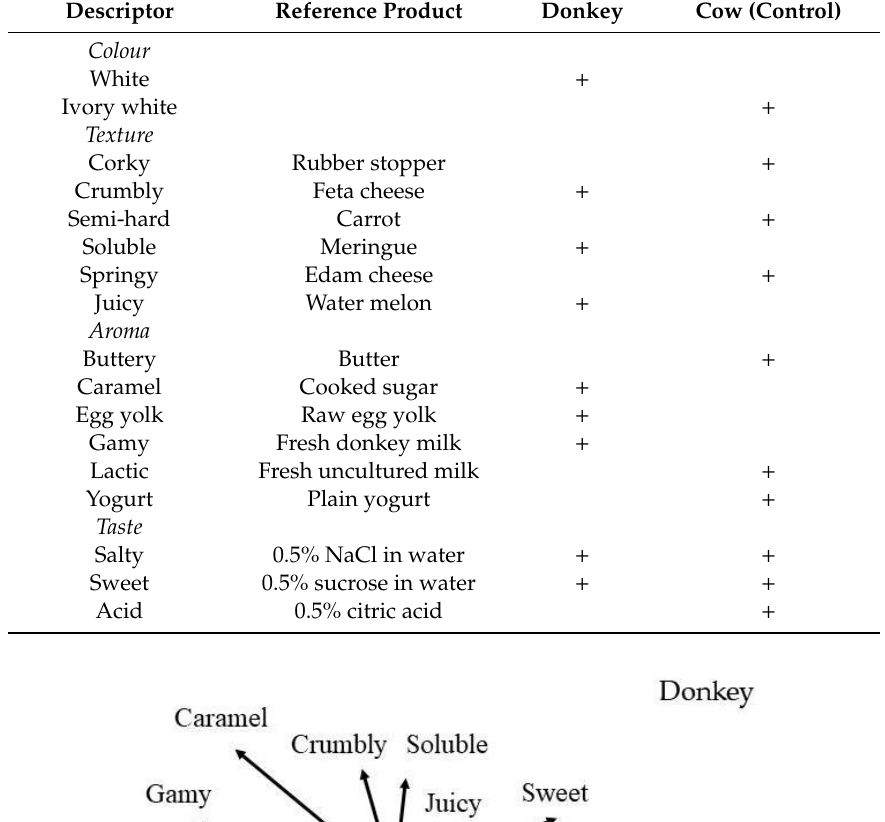
Table 5. List of descriptors and reference product developed for donkey cheese.